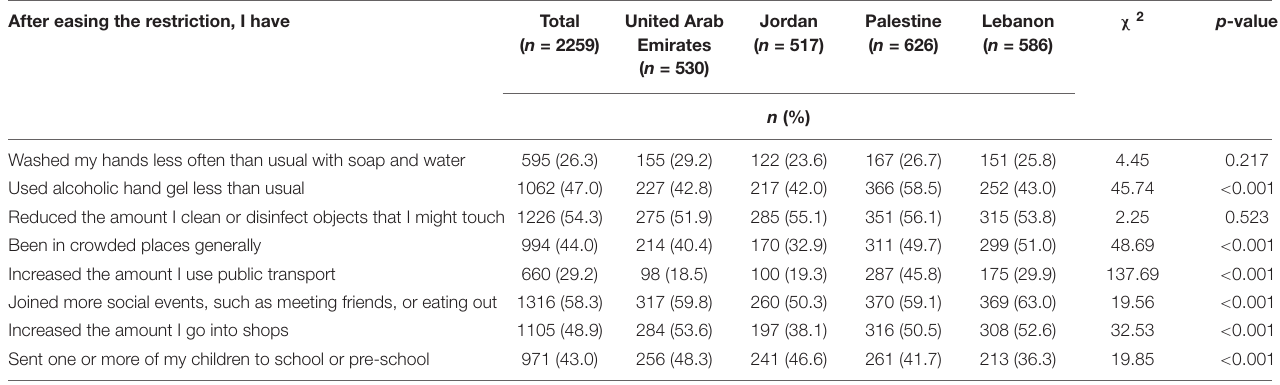
TABLE 3 | Behavioral responses after easing the restriction by country ( n =